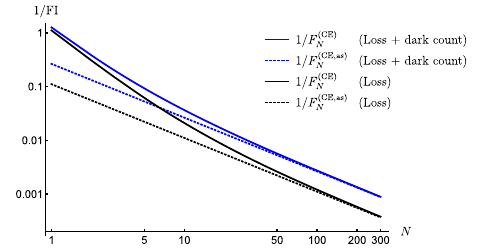
Fig. 10 | Ultimate bounds on precision in lossy photonic interferometry with dark counts and local unitary control. The solid and dotted blue lines are the inverse of the fi nite- N (evaluated via an SDP) and asymptotic (see Eq. (53)) CE bounds, respectively, for detection ef fi ciency η =0.9 and dark-count rate p =0 : 1. Controlgatesmayactoneachindividualdual-railphoton.Forcomparison,wealso plot, solid and dotted black lines, the corresponding quantities when only photon loss is present ( η =0.9, p